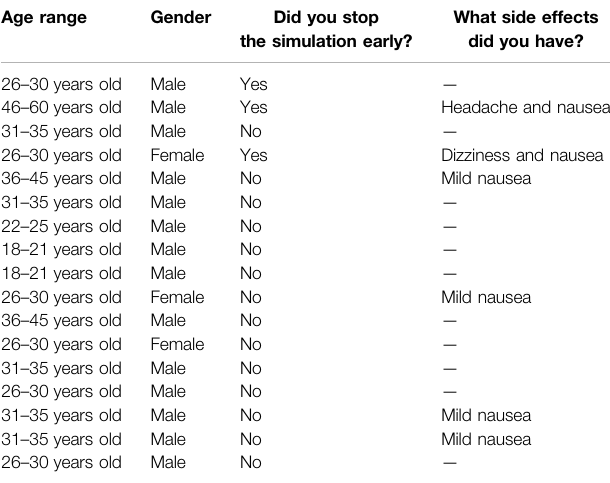
TABLE 4 | Side effect pro fi le experienced by users. TABLE 5 | Participant answers (post-survey) “ please list any other technical